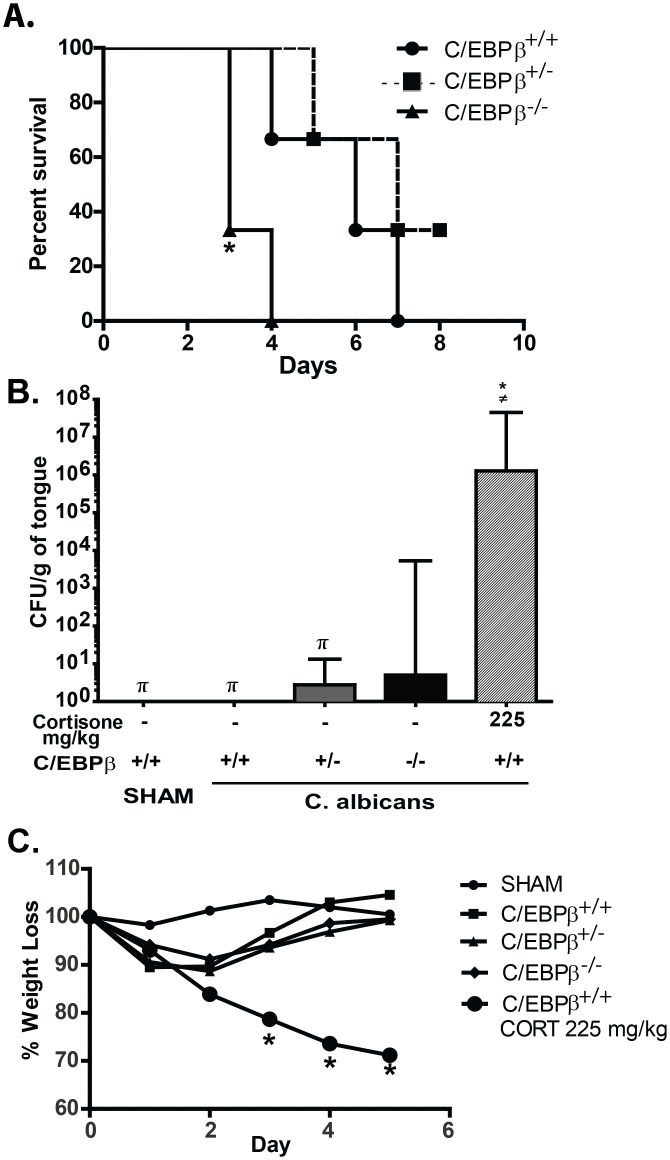
C/EBPβ-/- mice exhibit increased susceptibility to systemic candidiasis but are resistant to oral candidiasis.(A) The indicated mice (n = 3 per group) were injected with C. albicans in the lateral tail vein. Time to sacrifice is indicated (days). *P<0.05 versus (vs) C/EBPβ+/- mice using Log-rank (Mantel-Cox). (B) The indicated mice were infected sublingually with C. albicans for 75 mins. After 5 d, fungal loads in tongue were assessed by CFU enumeration of tongue tissue homogenates. Bars indicate geometric mean with 95% CI. C/EBPβ+/+ SHAM (n = 3), C/EBPβ+/+ (n = 5), C/EBPβ+/- (n = 9), C/EBPβ-/- (n = 3), C/EBPβ+/+ plus 225mg/kg cortisone (n = 3); cortisone acetate was administered by subcutaneous injection on days -1, +1 and +2 relative to infection. P<0.05 by t-test with Mann-Whitney correction: * vs C/EBPβ+/+ WT, ≠ vs C/EBPβ+/-, # vs C/EBPβ-/-, π vs C/EBPβ+/+ 225mg/kg. C. Weights of mice were assessed daily and graphed as percent of starting weight. * vs C/EBPβ+/+ WT. P<0.05 by t-test with Mann-Whitney correction. Experiment was performed once.